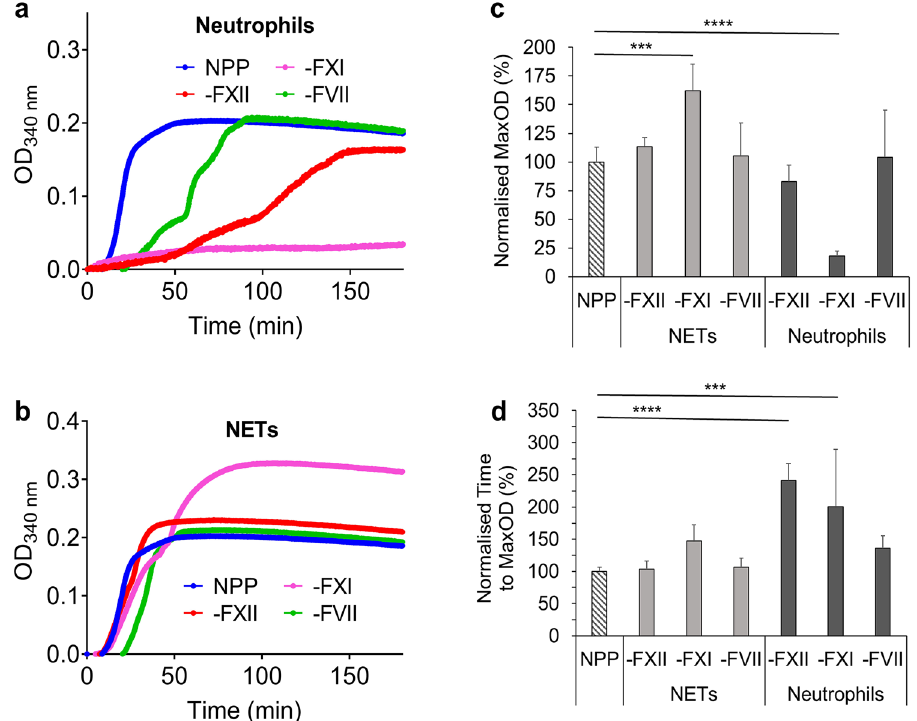
Figure 5. Turbidity analysis of the effect of human neutrophils and human NETs on FXII, FXI and FVII deficient plasmas. ( a ) Human neutrophils (200,000 cells/100 µl) or ( b ) human NETs (generated from 200,000 cells/100 µl) were added into FXII, FXI or FVII deficient plasmas, NPP was used as the positive control. ( c ) Normalized percentage of MaxOD and ( d ) normalized percentage of time to MaxOD were quantified. Other concentrations: plasmas (diluted 1:6) and CaCl 2 (3.33 mM). Error bars represent SD. NPP data represents 8 replicates, deficient plasma data represents 4–6 replicates. *** P < 0.001, **** P <